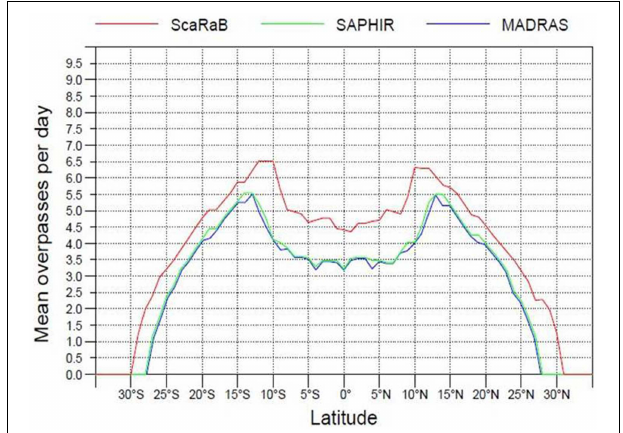
FIGURE 1 | Zonal statistics of observations by the Megha-Tropiques mission payloads. From Capderou (2009). For the ScaRaB instrument in red, the SAPHIR instrument in green and the MADRAS instrument in